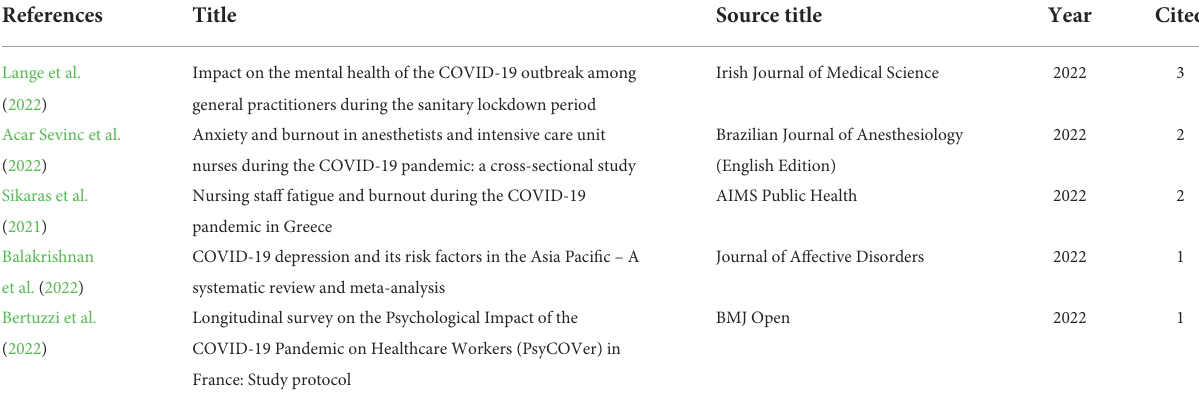
TABLE 3 Top 5 most global and local cited publications (2022).